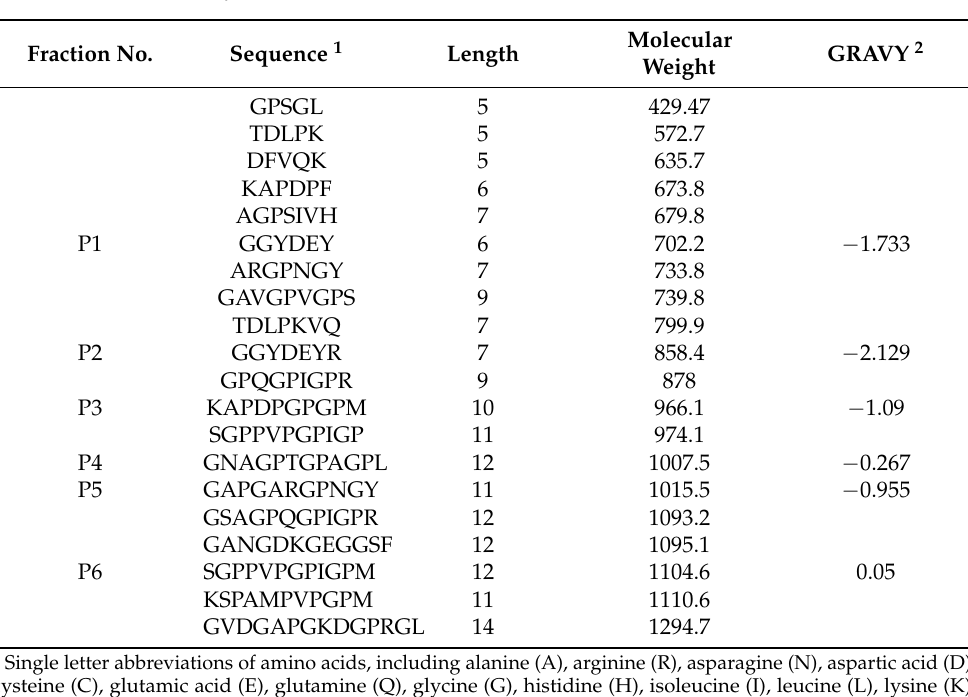
Table 2. LC–MS/MS identification and hydrophobicity index prediction of antioxidant peptides in H8 fractions obtained by PR-HPLC.